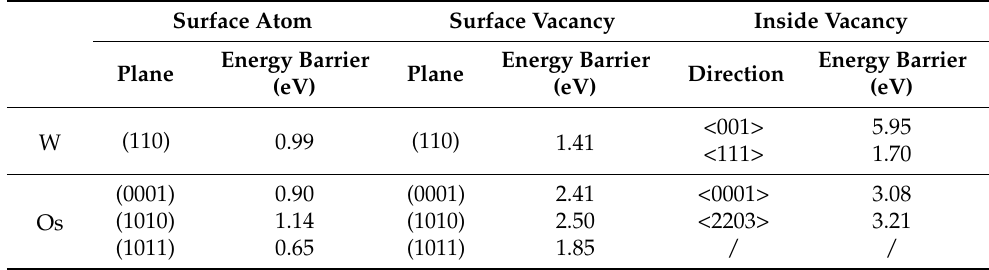
Table 3. Energy barrier of atom and vacancy migration on surface and in lattice of Os and W. Surface Atom Surface